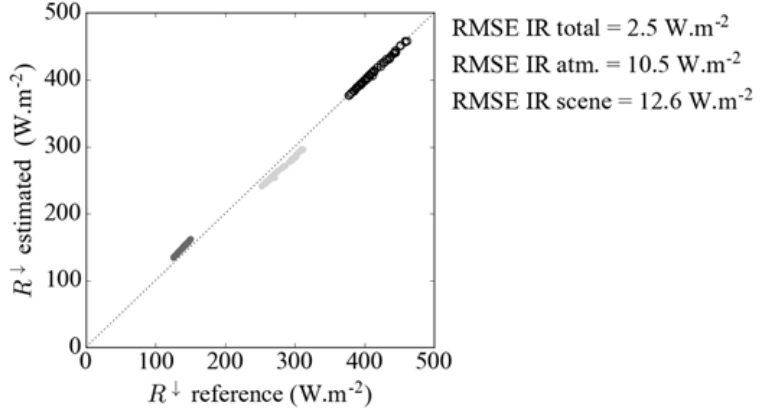
Figure 12. Comparison of estimated and reference total (black circles), atmospheric (dark grey dots) and scene (light grey dots) downwelling TIR radiation for a whole district.